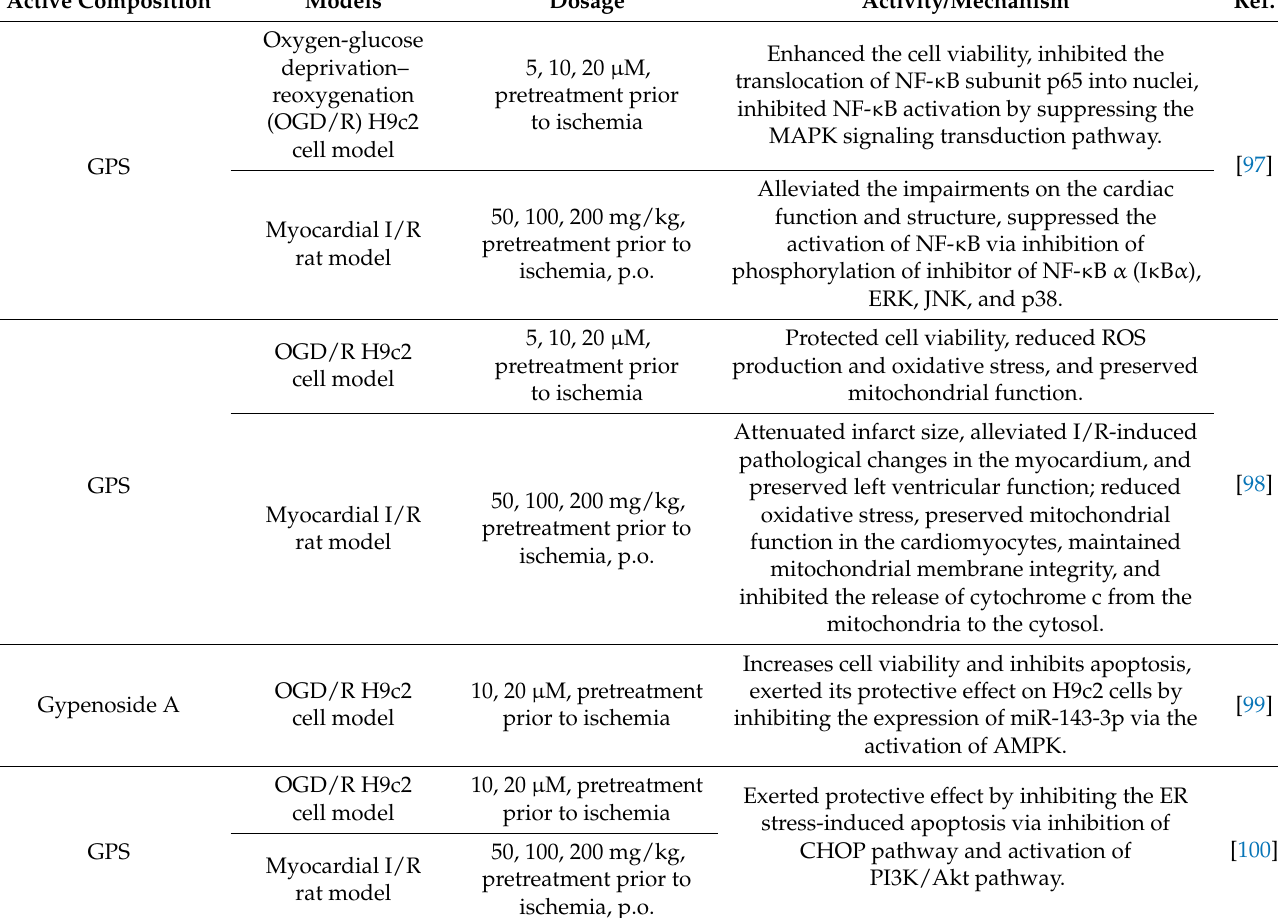
Table 4. Effects on ischemia–reperfusion(I/R)